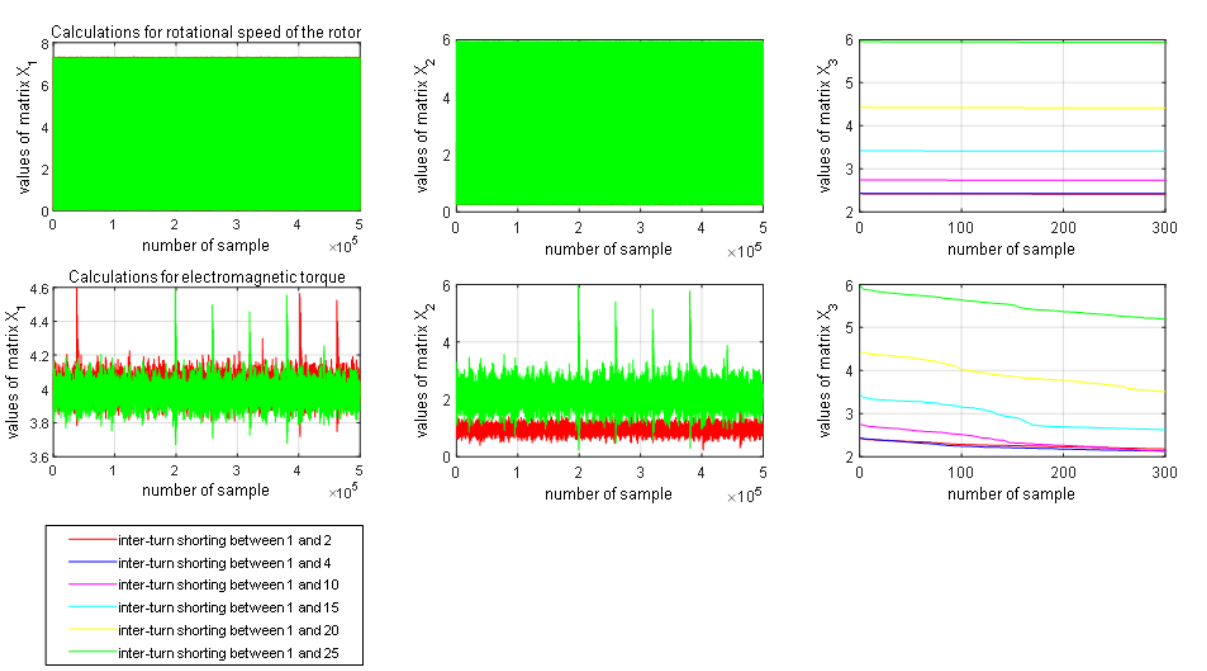
Figure 4. Presentation of the normalization of measurement data recorded in the X 1 matrix for the rotational speed n1 and the electromagnetic moment m el . The normalization was performed for the load current I load = 3A using the values of the variables a 3 and a 4 calculated for the axial flux φ 1 . The values of the X 2 matrix were sorted in descending order and stored in the X 3 matrix.